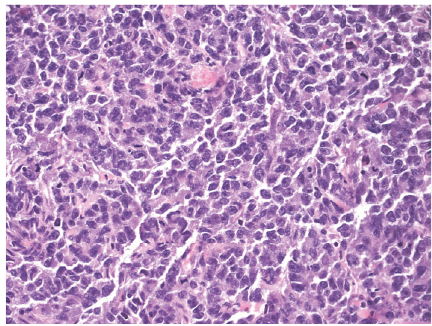
Figure 3: Duodenal mass, metastatic seminoma (H&E stain, mag- nification × 400).